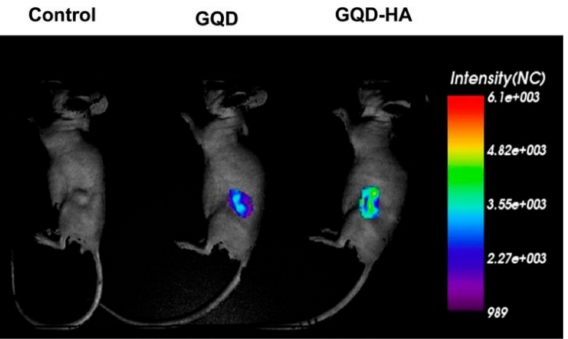
Figure 8. Comparison of HA-targeting ability of GQD-HA to the control and CNM alone. Reprinted with permission from Ref. [89]. Copyright 2013 American Chemical